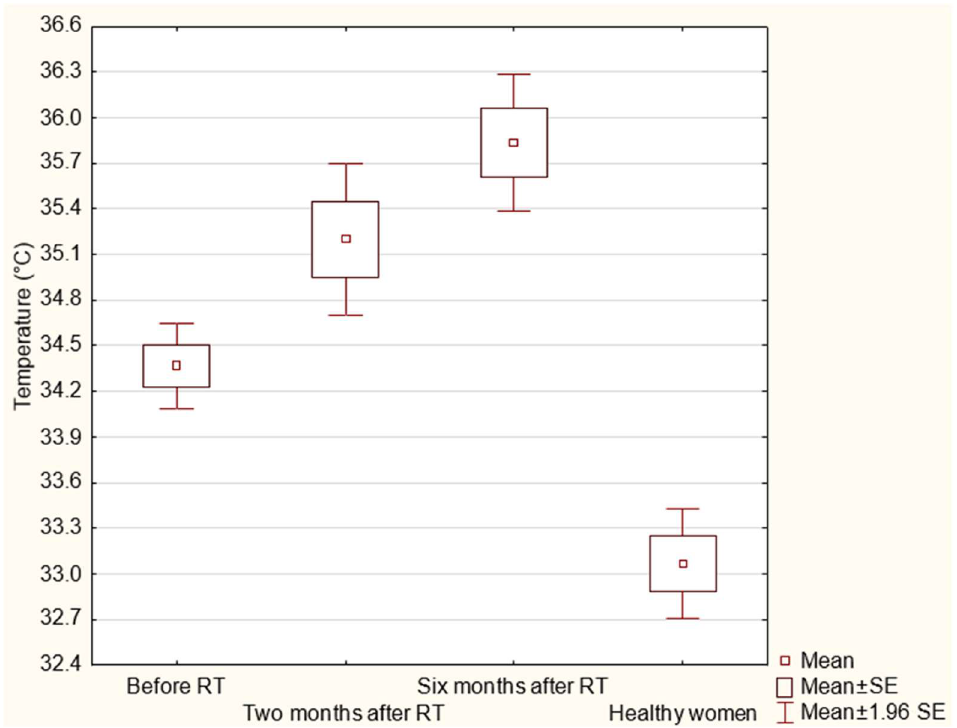
Figure 5. Breast area temperature values before radiotherapy, two months after treatment and six months after treatment at the same area for all patients and the healthy control group.